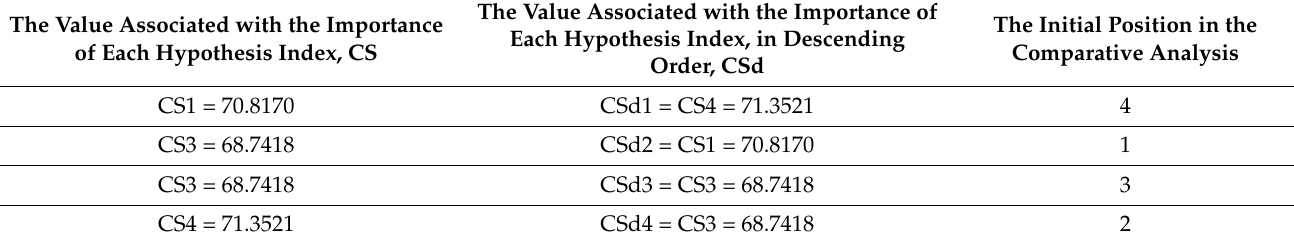
Table 5. The place obtained by the index of the importance of each hypothesis in the comparative